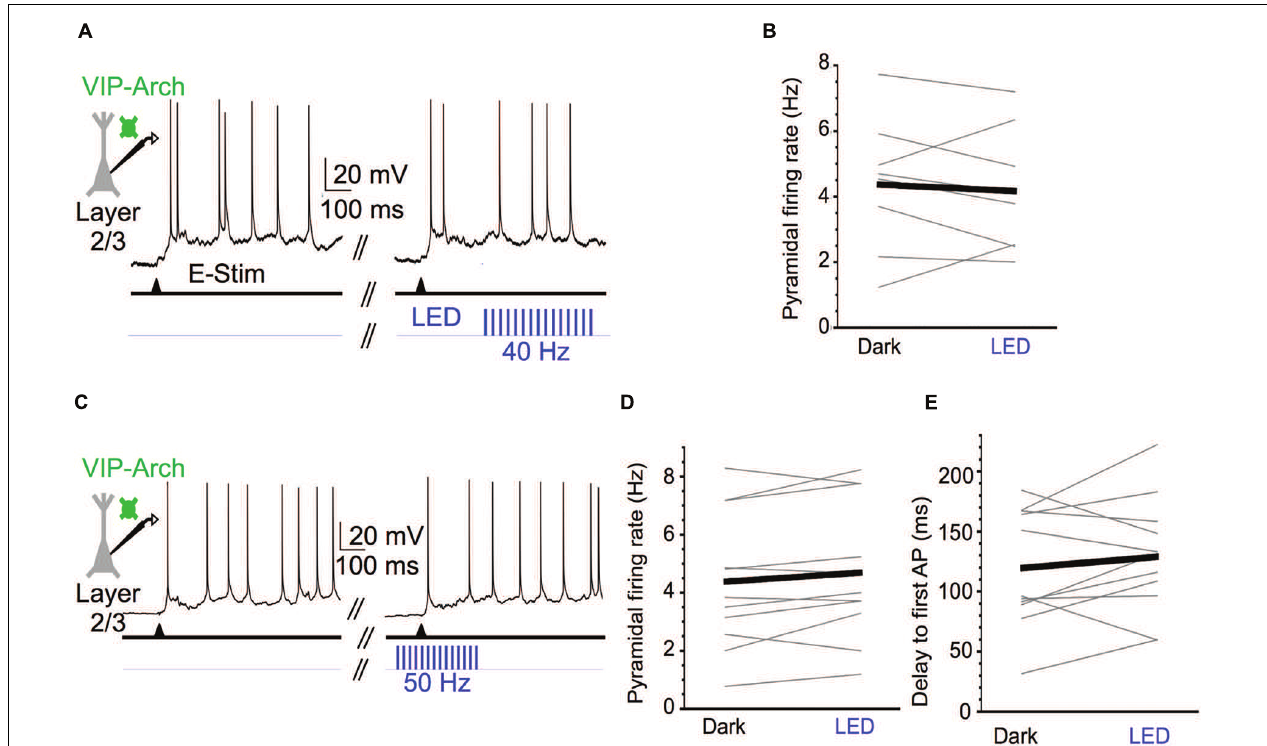
FIGURE 7 | Activating VIP cells during Up states does not affect pyramidal cell excitability. (A) Representative Up state membrane potential trace of a layer 2/3 pyramidal cell with and without optogenetic stimulation of Arch-expressing VIP cells in layer 2/3. (B) Population data demonstrating layer 2/3 pyramidal cell Up state firing rates do not significantly change when VIP cells are activated at 40 Hz ( n = 8 cells; Dark: 4.4 ± 0.7 Hz, LED: 4.2 ± 0.7 Hz, P = 0.12, paired t -test). (C) As in (A) , but for a layer 2/3 pyramidal cell in which 50 Hz light stimuli were turned on before Up state onset and remained on for the first 250 ms of the Up state. (D) Population data demonstrating layer 2/3 pyramidal cell Up state firing rates do not significantly change when VIP cells are activated during Up state onset ( n = 11 cells, different set of neurons than in B ; Dark: 4.4 ± 0.7 Hz, LED: 4.7 ± 0.7 Hz, P = 0.60, paired t -test). (E) As in (D) , but population data are delays from electrical stimulation to firing of the first action potential during an Up state ( n = 11 cells, same set of neurons as in D ; Dark: 119.5 ± 14.8 ms, LED: 128.9 ± 14.8 ms, P = 0.34, paired t